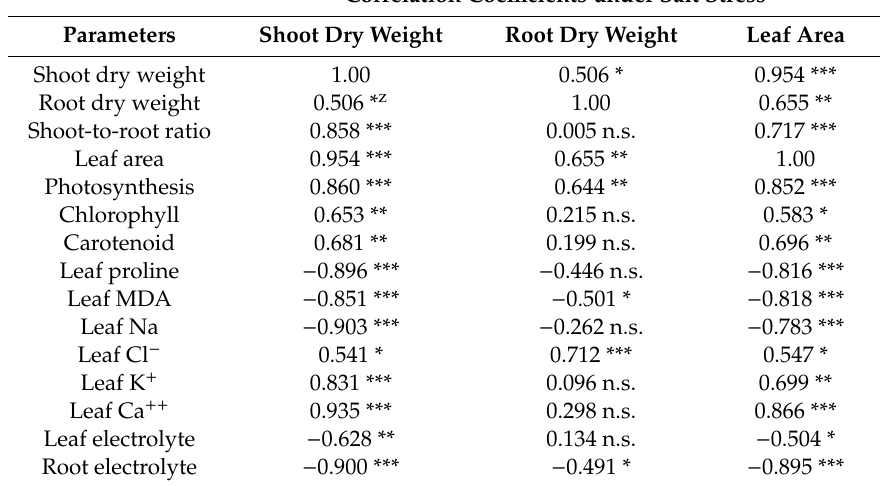
Table 4. Irrespective of the graft combination, the correlation coe ffi cients between shoot and root dry biomass productions, leaf area formation, and other parameters of melon plants under salt stress (8.0 dS m − 1 )